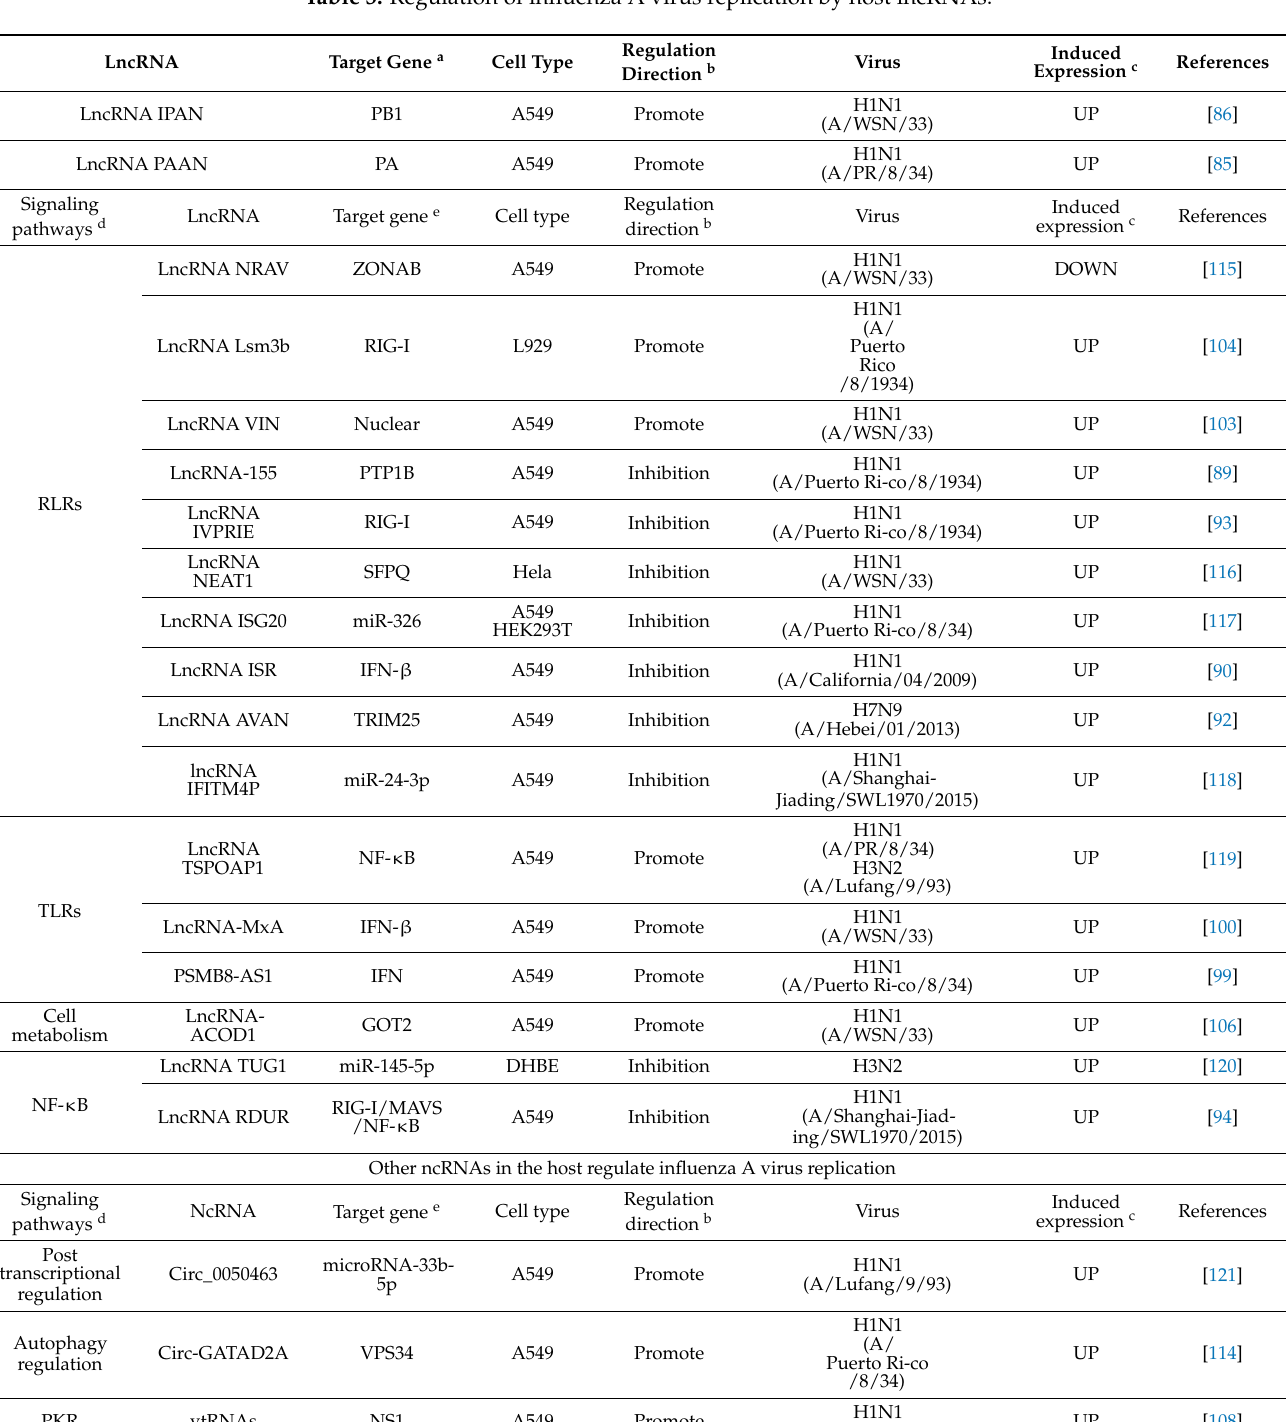
Table 3. Regulation of influenza A virus replication by host